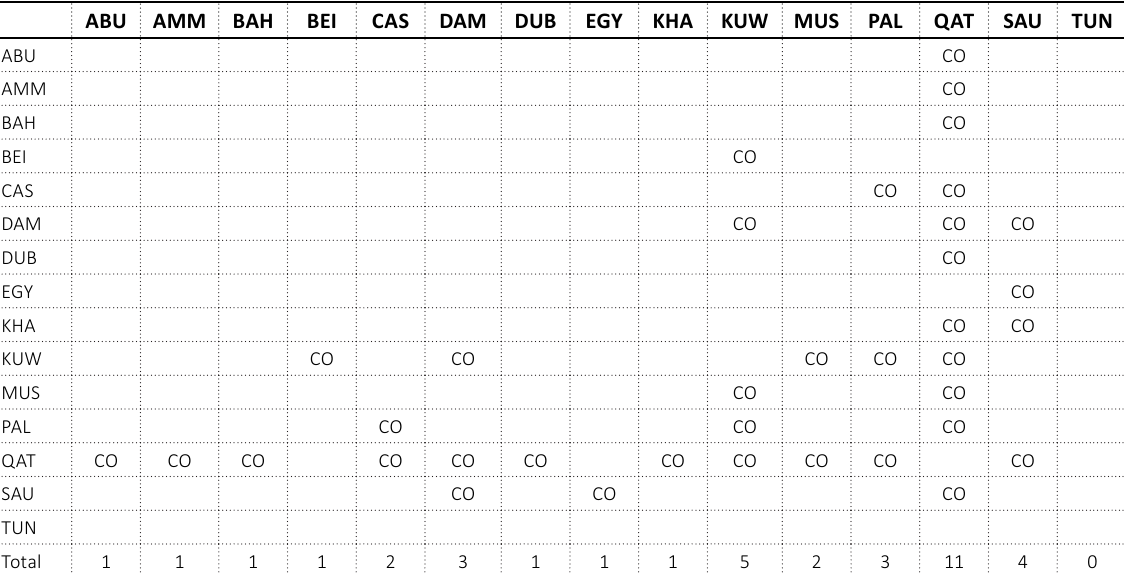
Table 5. Summary results of testing the